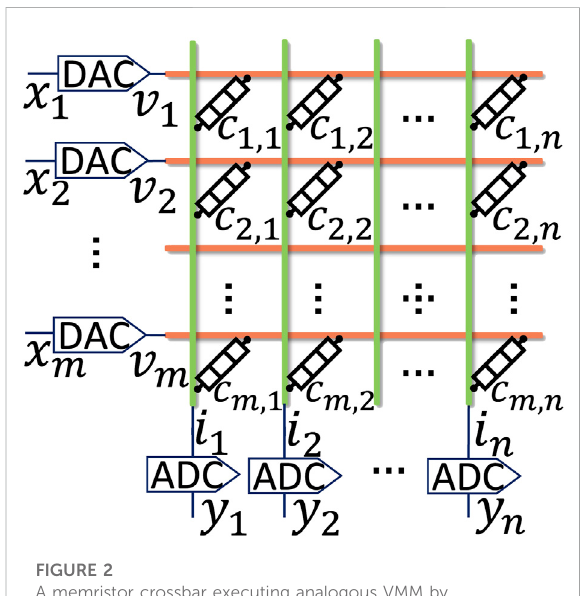
FIGURE 2 A memristor crossbar executing analogous VMM by accumulating currents at its BLs: the accumulated current at the v i · c i , j j th BL is (cid:3) m i (cid:1) 1